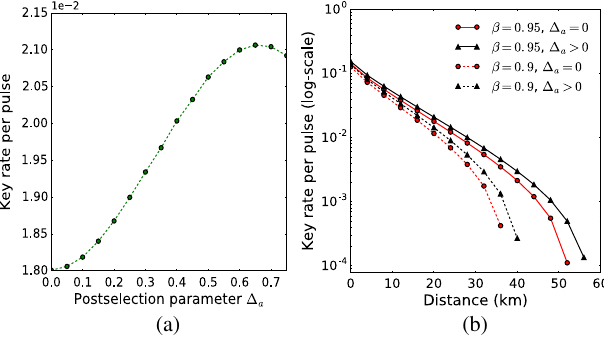
FIG. 10. Secure key rate for protocol 2 (heterodyne detection) with postselection. The excess noise is ξ ¼ 0 . 04 , the coherent state amplitude is α ¼ 0 . 6 , and one of the postselection param- 0 . (a) Secure key rate versus the postselection eters is Δ p ¼ parameter Δ at the distance L ¼ 20 km. The reconciliation a efficiency is β ¼ 0 . 95 . (b) Secure key rate versus the transmission distance with or without postselection for two different values of reconciliation efficiency β . Solid lines have β ¼ 0 . 95 , and dashed 0 , lines have β ¼ 0 . 9 . Lines with (red) circle markers have Δ a ¼ and lines with (black) triangle markers have Δ optimized via a a coarse-grained search in the interval [0.4,